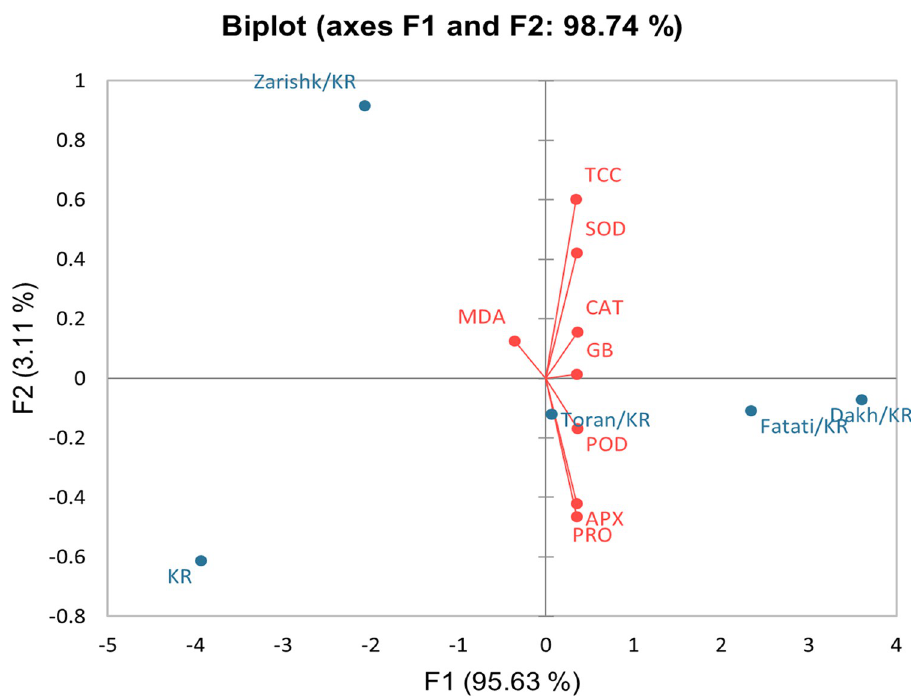
Fig 18. Bi-plot graph of the first (PC1) and second (PC2) principal components of enzymatic and non-enzymatic biochemical traits in un-grafted and grafted Kings Ruby scion variety on different wild grapevines under -8 bars of drought stress.